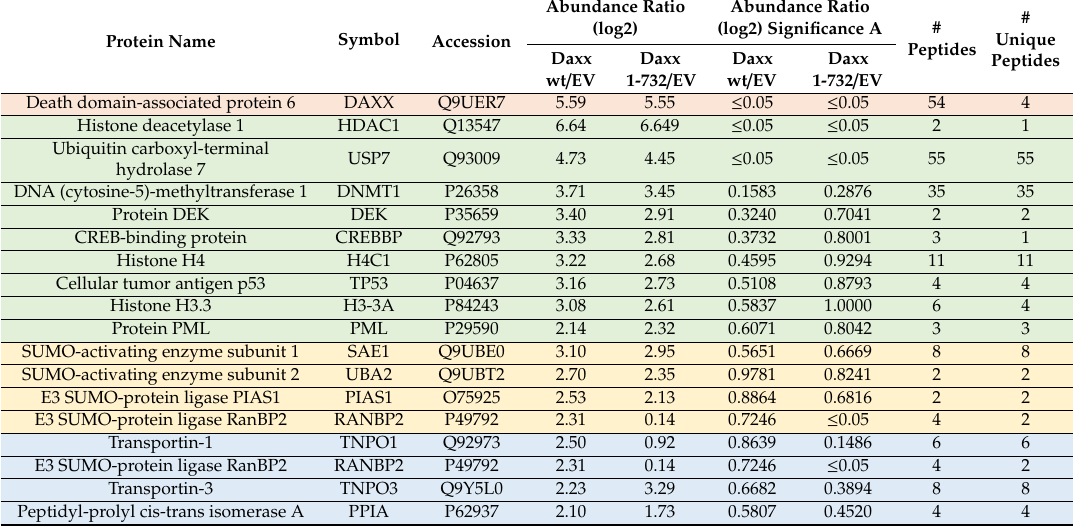
Table 1. Proteins interacting with Daxx wt or Daxx 1-732, identified using stable-isotope labeling by amino acids in cell culture